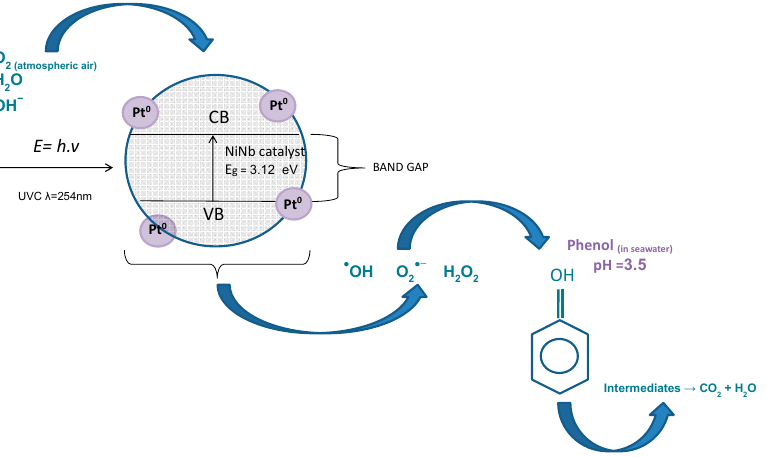
Figure 11. Scheme of the proposed mechanism (CB: conducting band; VB: valency band; E g : band-gap energy). Source: prepared by the author.